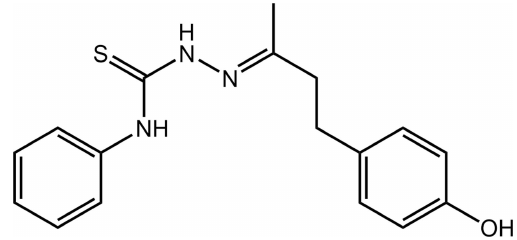
Table 1 Hydrogen-bond geometry (A˚ , (cid:2) ).